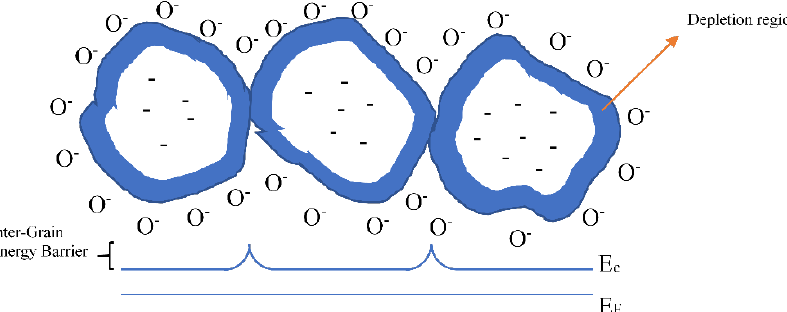
Figure 9. Grain representation with the depletion regions, Fermi level (EF), conduction band (Ec) and inter-grains barrier due to the oxygen ionosorption.